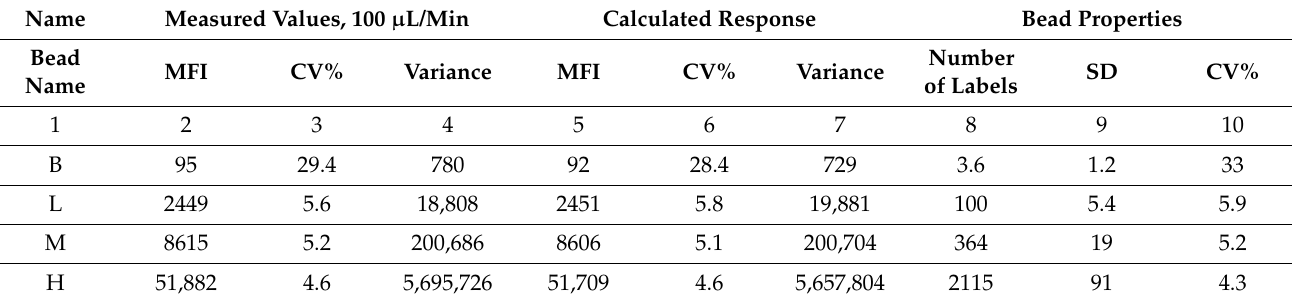
Table 4. Measured and calculated response. The number of labels on L, M, and H beads were adjusted to yield the calculated response shown in the table. The properties of the background bead, B, remained unchanged for the calculations of the other